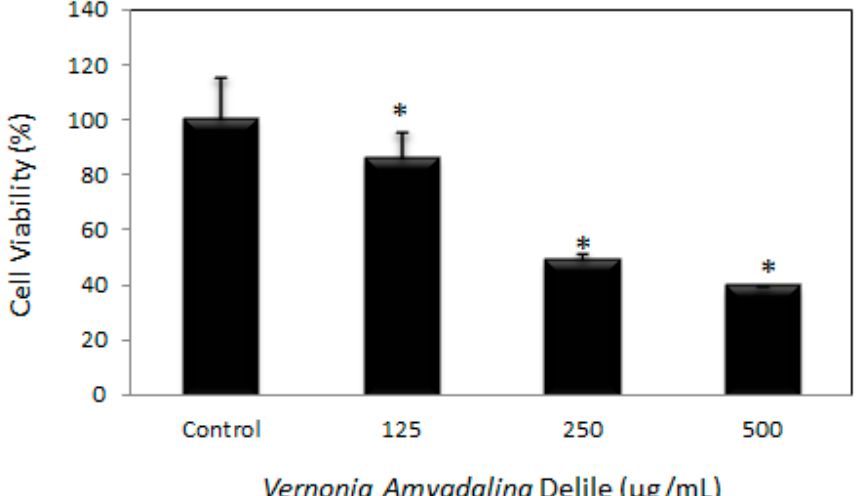
Figure 2. Antiproliferative effect of Vernonia amygdalina Delile (VAD) on PC-3 cells. Growth inhibition of PC-3 cells treated with different doses of VAD for 48 h and measured by MTT assay as described in Materials and Methods section. Data are expressed as means ± SD ( n = 3). * Significantly different from the control by ANOVA and Dunnett’s test; p < 0.05.